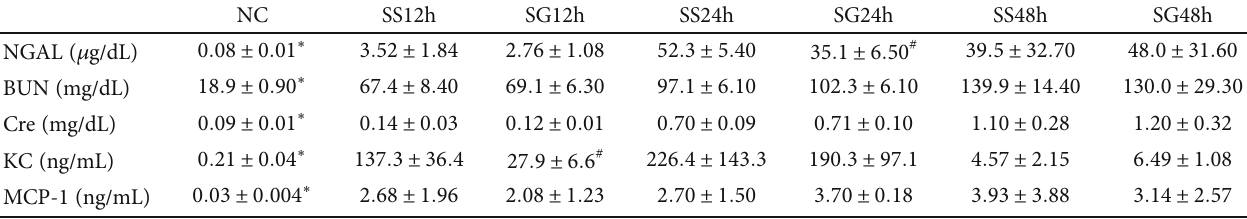
Table 3: Plasma concentrations of kidney function marker and in fl ammatory chemokine among groups. NC SS12h